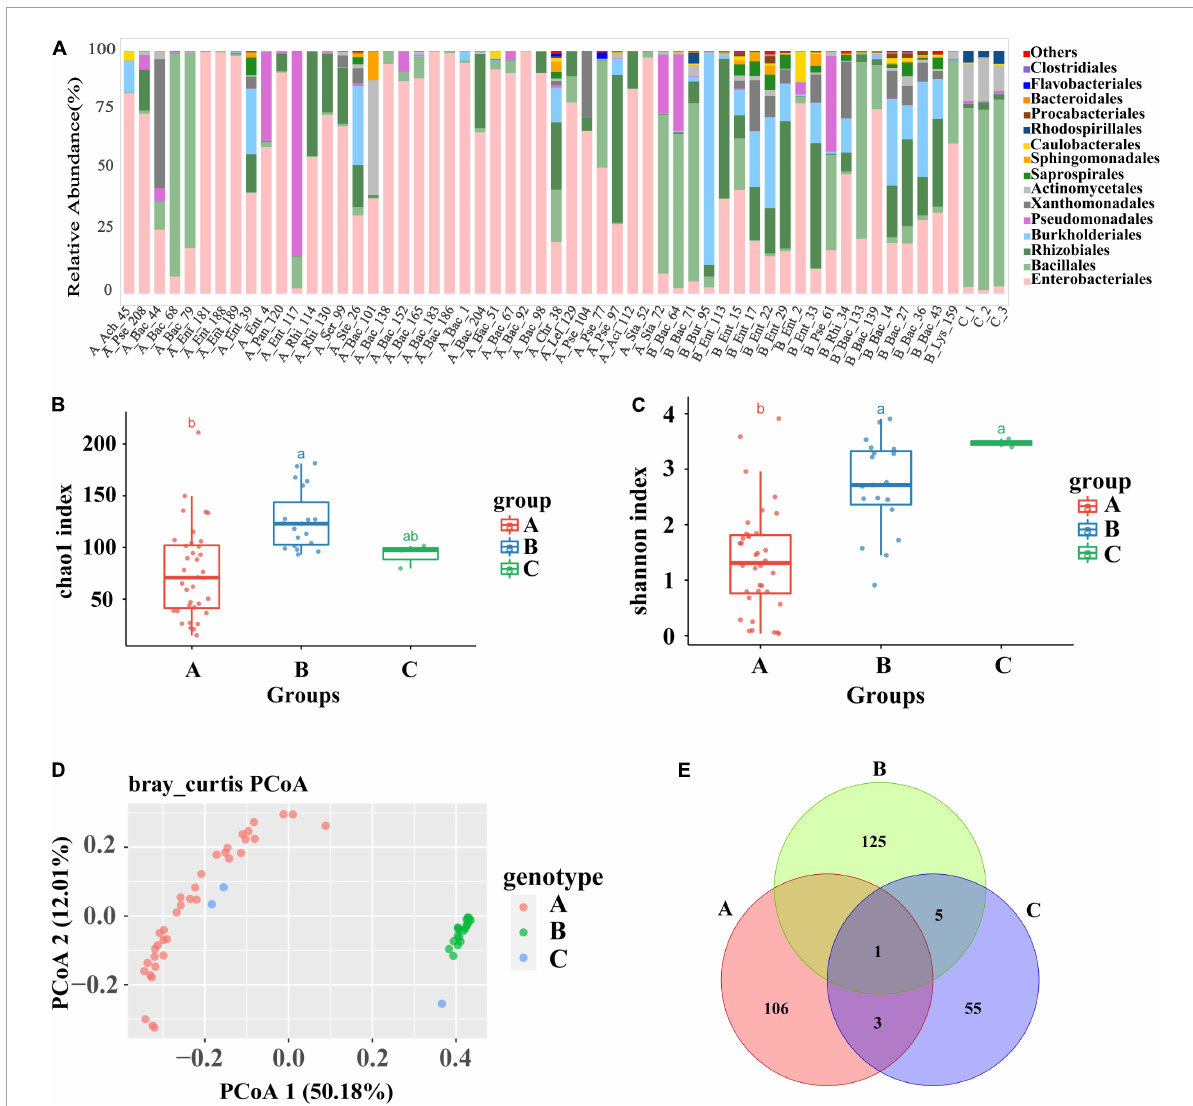
FIGURE1 Analysis of the composition and diversity of the flora of the roots of tomato infested with 55 single bacteria and the control group. (A) Diagram of the species structure of 55 single bacteria and the control group (at the order level, selecting the top 15 flora in terms of abundance). (B,C) The Chao1 boxplot and Shannon boxplot of 55 single bacteria and control group (the letters above represent the differences between groups). (D) PCoA plots of 55 single bacteria and the control group, principal coordinated analysis (PCoA) derived from dissimilarity matrix of Unweighted UniFrac distance. (E) A Venn plot of 55 single bacteria and the control group. Among them, 55 single bacteria were divided into group A and group B due to the difference in the diversity of root